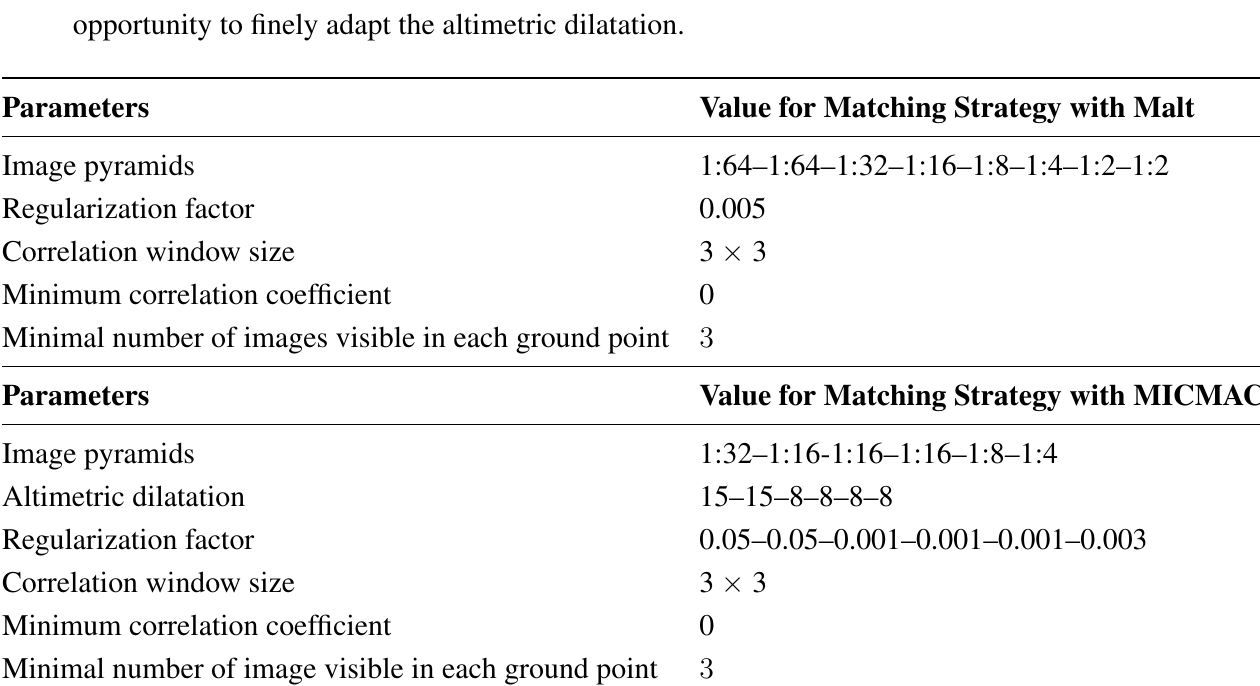
Table 1. Parameters applied for multi-image, multi-resolution digital surface model (DSM)